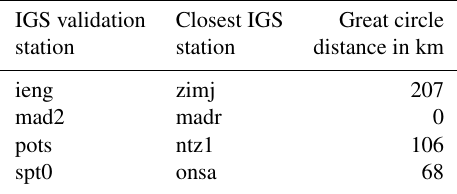
Table 1. Overview on the validation stations used and their closest IGS station in the surrounding area. The great circle distance be- tween the corresponding two stations is given under the assumption of a spherical Earth with a radius of